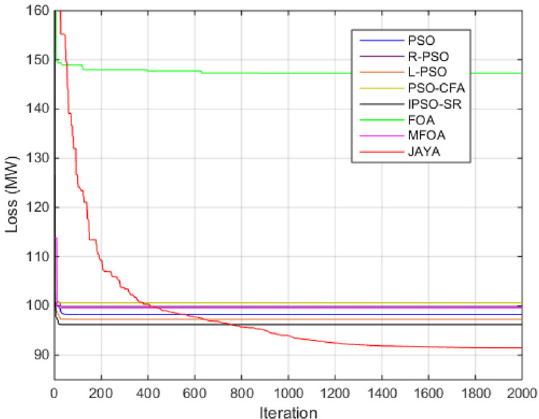
Fig. 13 Convergence characteristics of the algorithms for IEEE 118 bus system with